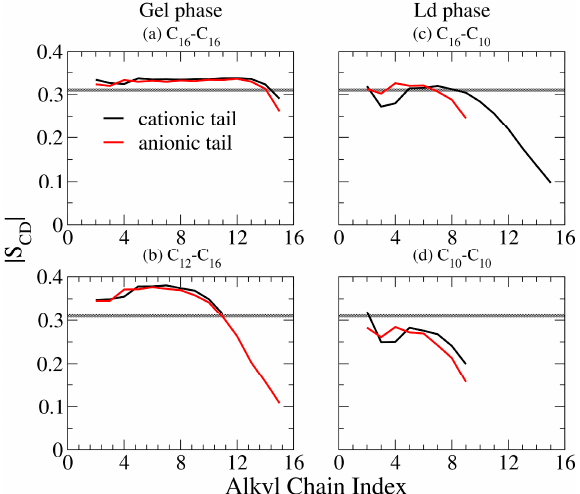
Figure 6. Representative deuterium order parameter |S CD | profiles for the cationic (black line) and the anionic (red line) components of the IPA systems ( a ) C 16 TMA + -C 16 S − and ( b ) C 12 TMA + -C 16 S − in gel (S) phase, and ( c ) C 16 TMA + -C 10 S − and ( d ) C 10 TMA + -C 10 S − systems in liquid-disordered (Ld) phase. The gray lines represent the threshold value of |S CD | = 0.31 to distinguish the Ld and S phases.